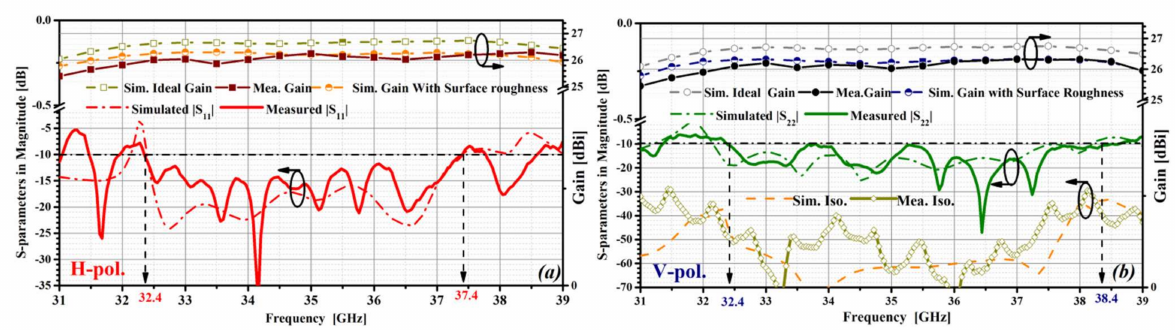
Figure 11. S-parameters and gain of the 8 × 8-unit dual-polarization ME-dipole antenna array: ( a ) performance of the H-pol. array; ( b ) performance of the V-pol. array.